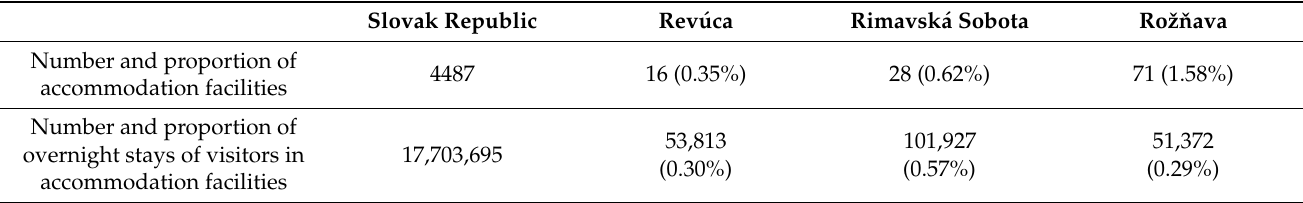
Table 2. Capacities and performances of accommodation facilities in